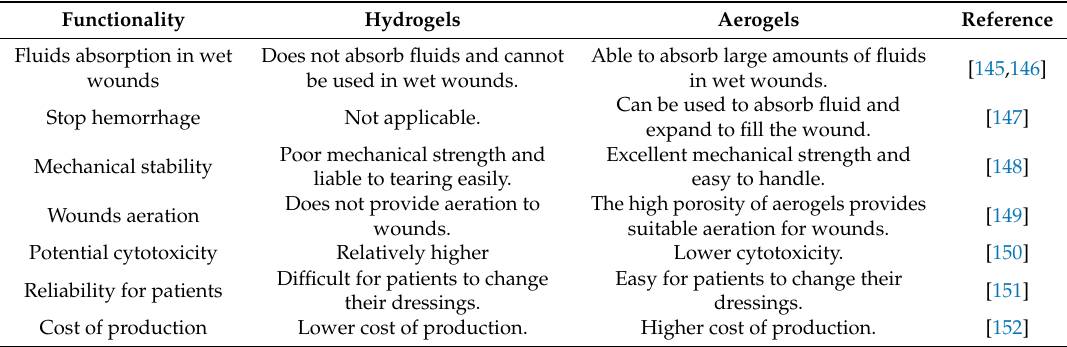
Table 3. Comparison between hydrogel and aerogel in wound healing applications. Functionality Hydrogels Aerogels Reference Fluids absorption in wet